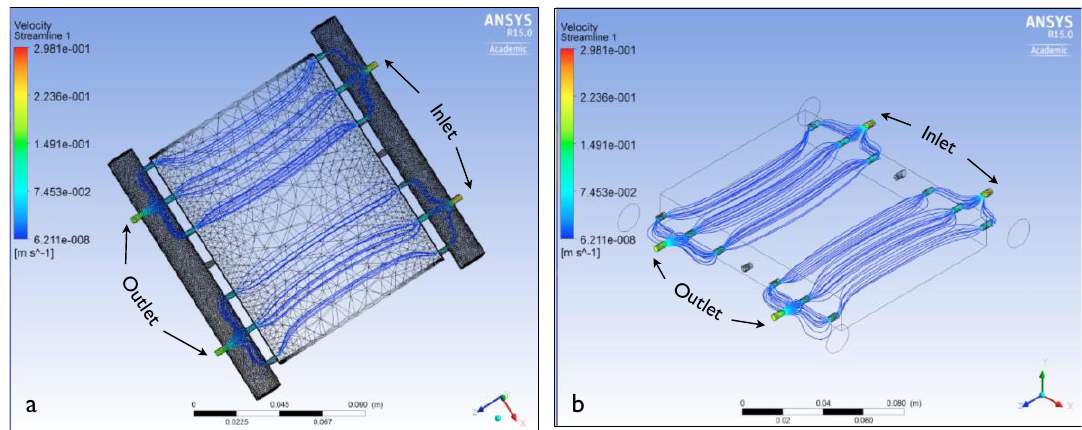
Figure 5. ANSYS model that simulates gas flows in a growth chamber with no deflectors. ( a ) Top view and ( b ) lateral view.